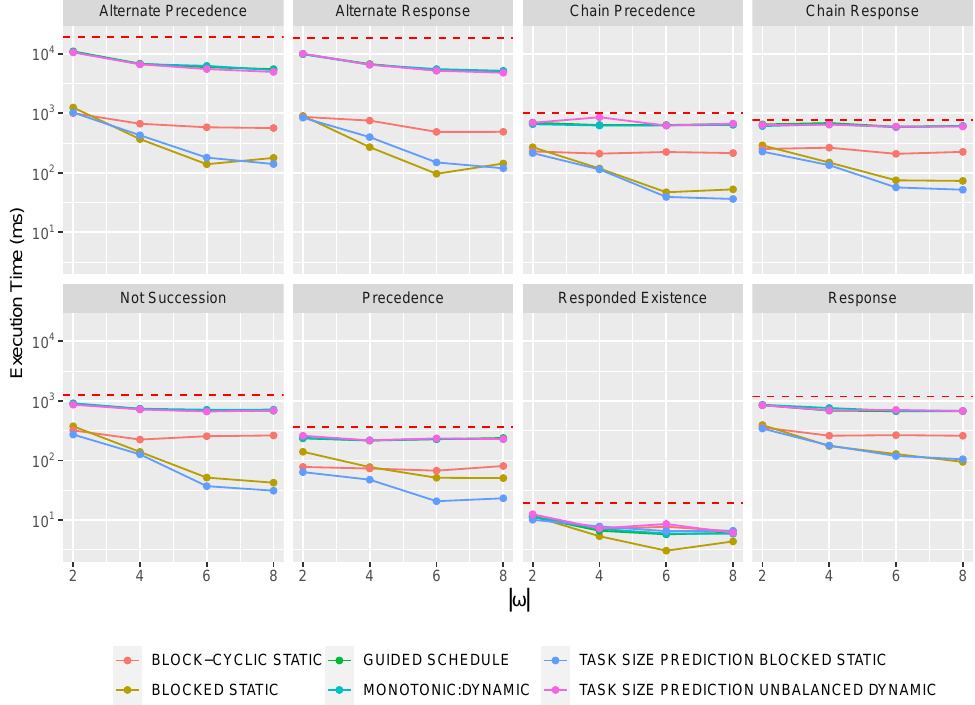
Figure 12. Results for parallelisation Section 7.3. ω indicates the set of threads in the thread pool, and the red dashed horizontal lines indicate running times for single threaded